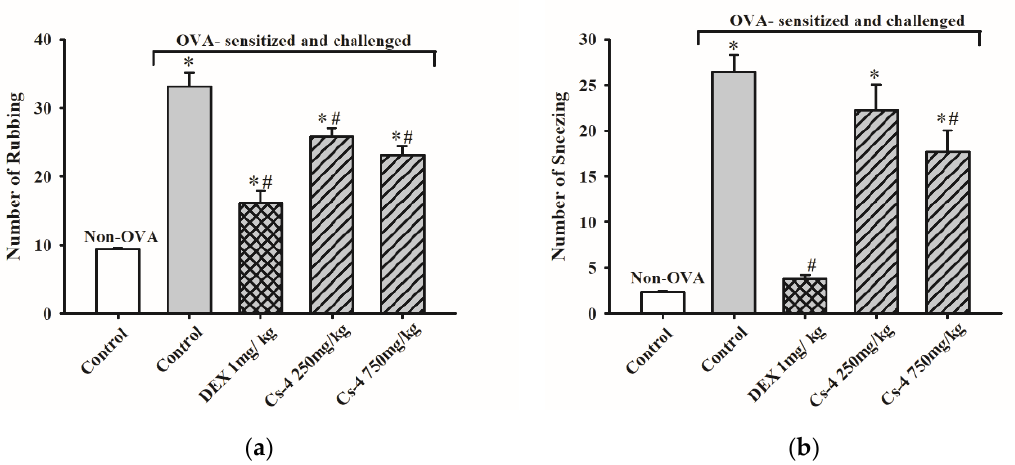
Figure 1. The effect of Cs-4 on the nasal symptoms of ovalbumin (OVA)-sensitized and challenged mice. Nasal symptoms of ( a ) nose rubbing and ( b ) sneezing were observed. Each bar represents the mean ± S.E.M., with n = 5. * Significantly different from the non-OVA control group. # Significantly different from the OVA-sensitized and challenged control group. DEX: dexamethasone.